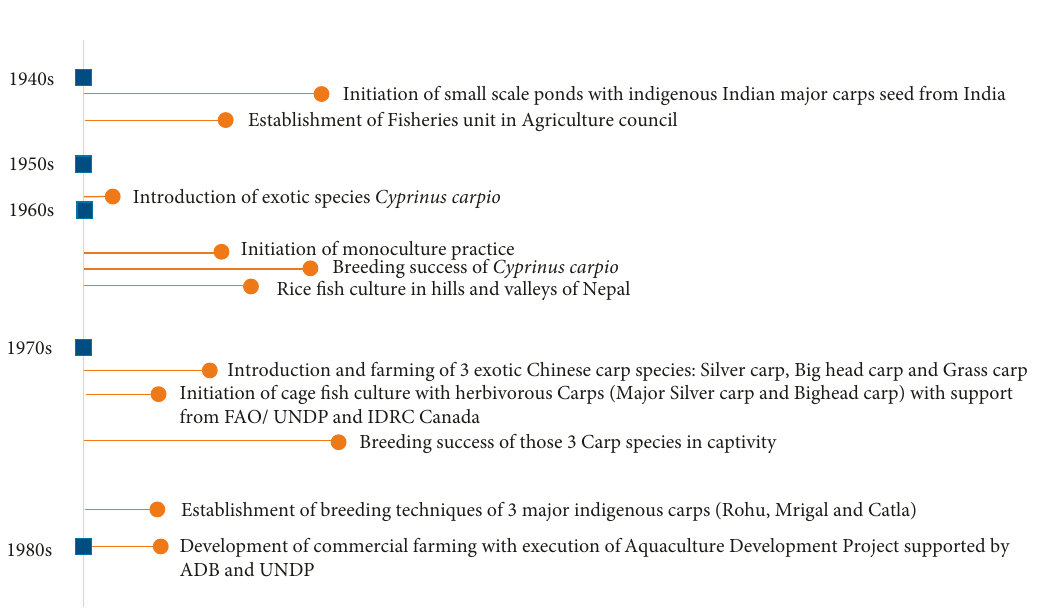
Figure 3: General overview of aquaculture history in Nepal, source: information obtained and modified from [24, 25]. Table 1: Natural water sources in